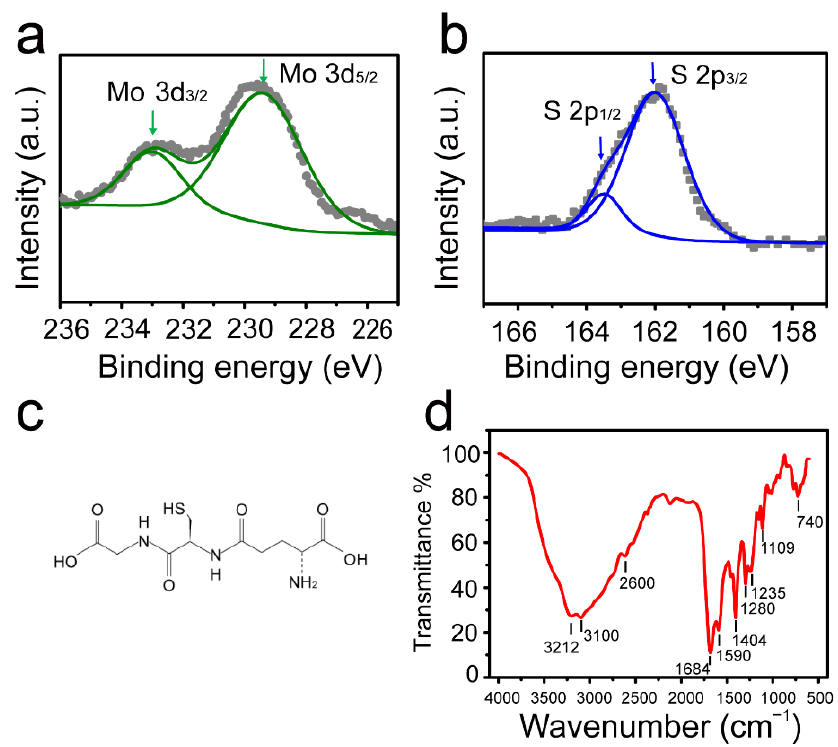
Figure 2. ( a , b ) Typical XPS response in Mo 3d and S 2p regions, and the solid line shows the fitting result of experimental data; ( c ) formula of GSH; ( d ) FTIR spectrum of surface functionalized MoS 2 QDs with carboxyl, amino and thiol groups.